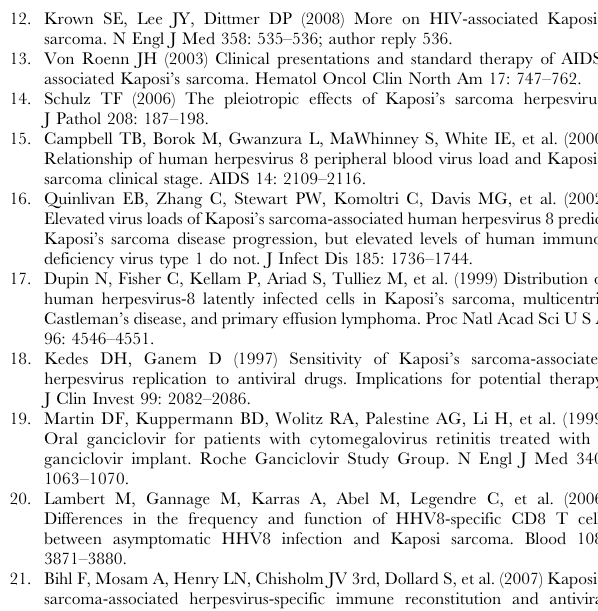
prior to their incubation with KSHV. Relative infection rates were determined for all groups as previously described. Error bars represent the S.E.M. for three independent experiments. Figure S2 KSHV miRNAs induce RNS release by macrophages independent of toll-like receptor pathway activation. (A) RAW cells were transiently transfected with either control or miRNA- expressing vectors for 24 h, then incubated with 10 mM 2- aminopurine (2-AP) or vehicle control for 3 h. (B) In parallel, RAW cells were transfected as in (A), then incubated with 100 m M of a control peptide or MyD88 inhibitor peptide for 24 h prior to nitrite quantification within culture supernatants. Error bars represent the S.E.M. for three independent experiments. *=p , 0.05. Figure S3 L-NMMA induces no discernable toxicity for RAW cells. RAW cells were incubated with the indicated concentrations of L-NMMA and cell viability determined after 48 h by standard MTT assay according to the manufacturer’s instructions. Error bars represent the S.E.M. for three independent experiments. Found at: doi:10.1371/journal.ppat.1000742.s003 (0.09 MB TIF) Figure S4 Advanced KS lesions contain more KSHV-infected cells relative to early-stage lesions. Representative early (I) and late (III) stage lesions were processed for immunohistochemistry as described in Methods using secondary antibodies alone (control) or anti-LANA antibodies followed by secondary antibodies (LANA). LANA expression is indicated by dark brown, punctate intranu- clear staining seen best at higher power (representative LANA + cells are identified with red arrows). Images are shown at original magnification 6 20 or